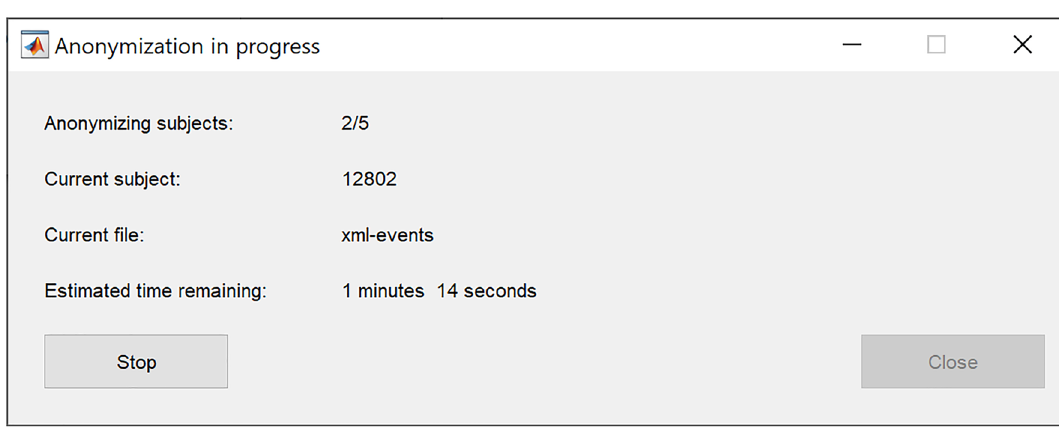
Figure 5. Anonymization selection window.